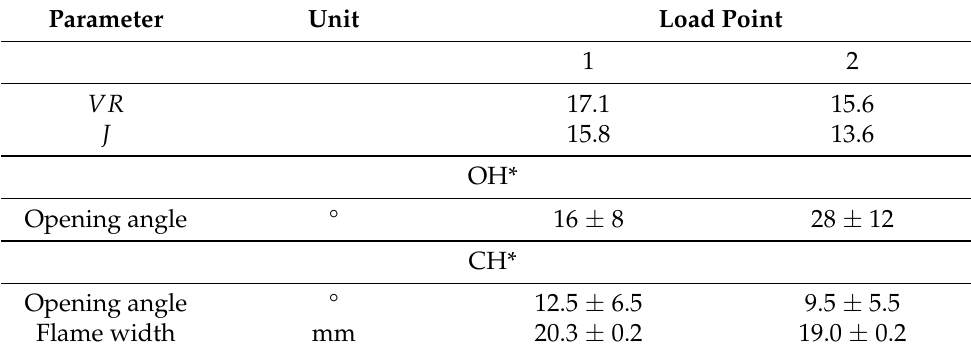
Figure 11. Time-averaged flame radiation imaging (OH*/CH*) of LP2. The injection parameters (VR and J ) with the derived geometrical flame parameters (flame width and opening angle) are summarized in Table 3. Table 3. Injection parameters and flame topology for both load